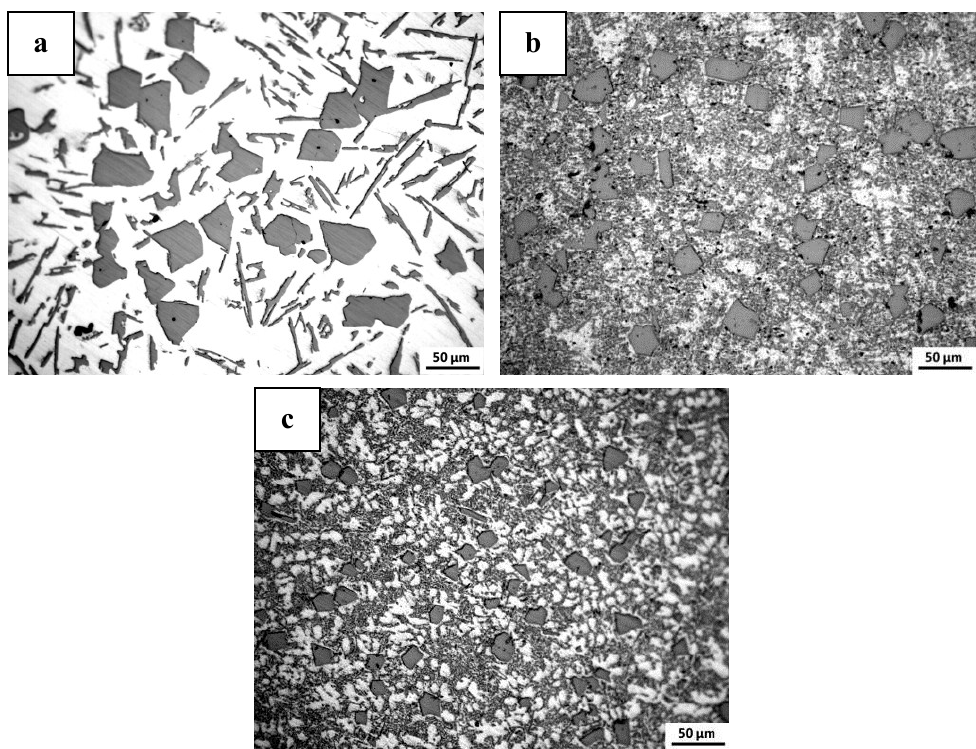
Figure 6. Microstructures of Al-17%Si alloy ingots modified by different FSM master alloy: ( a ) unmodified; ( b ) 20% FSM master alloy prepared with water-cooled copper mold; ( c ) 20% FSM master alloy prepared by melt spinning process.